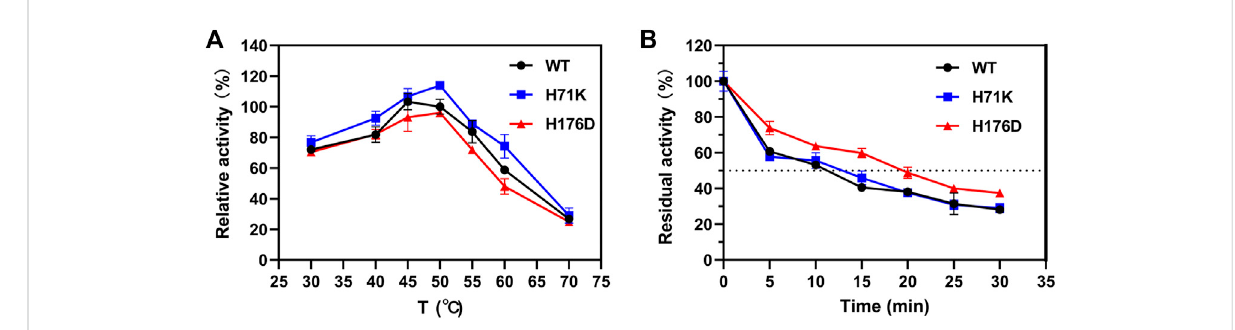
FIGURE 4 Enzymatic properties of WT and mutants. Effects of temperature on the activity (A) and stability (B) of WT and mutants. Error bars are standard deviation of three